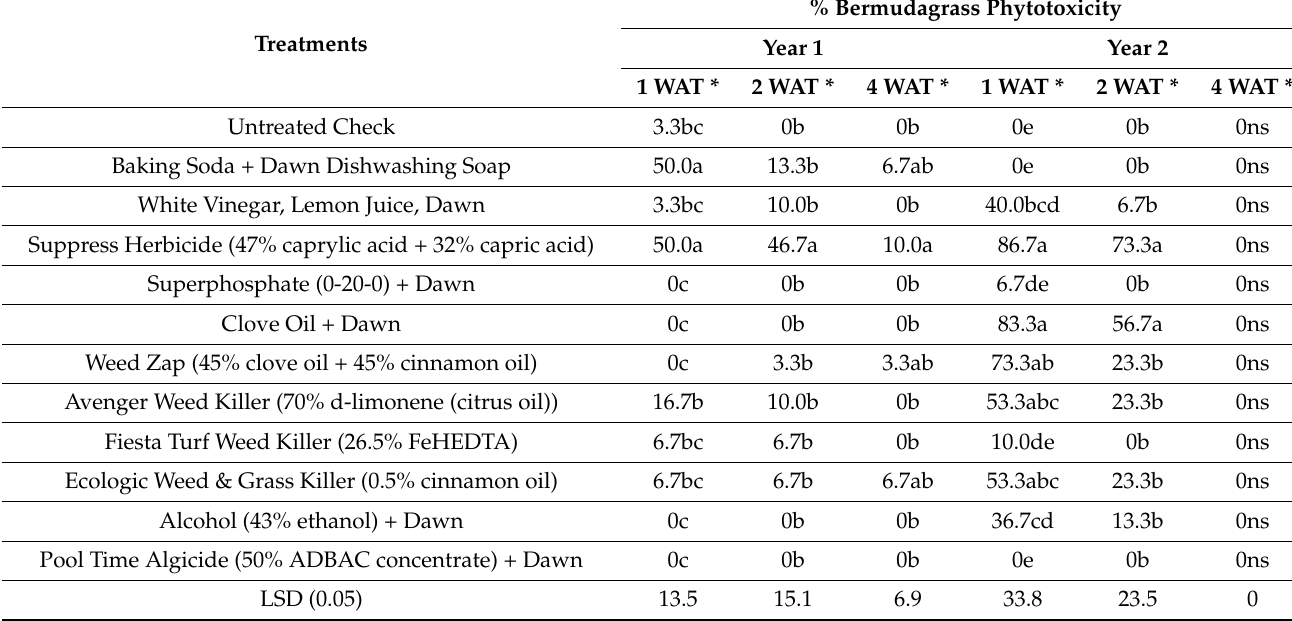
Table 3. Phytotoxicity of TifEagle bermudagrass from non-synthetic annual bluegrass control treatments. Different letters within a column indicate statistical differences.